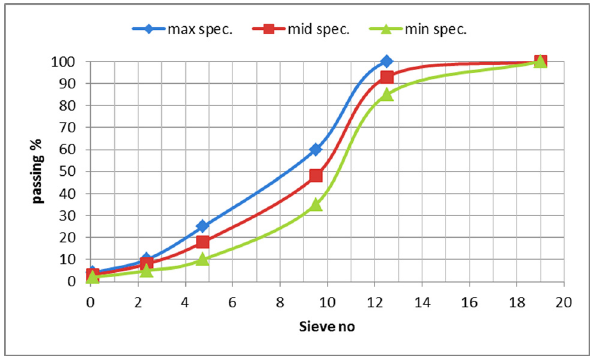
Figure 1: Thegradationofaggregate ( coarseand fi ne ) dependson [ 18